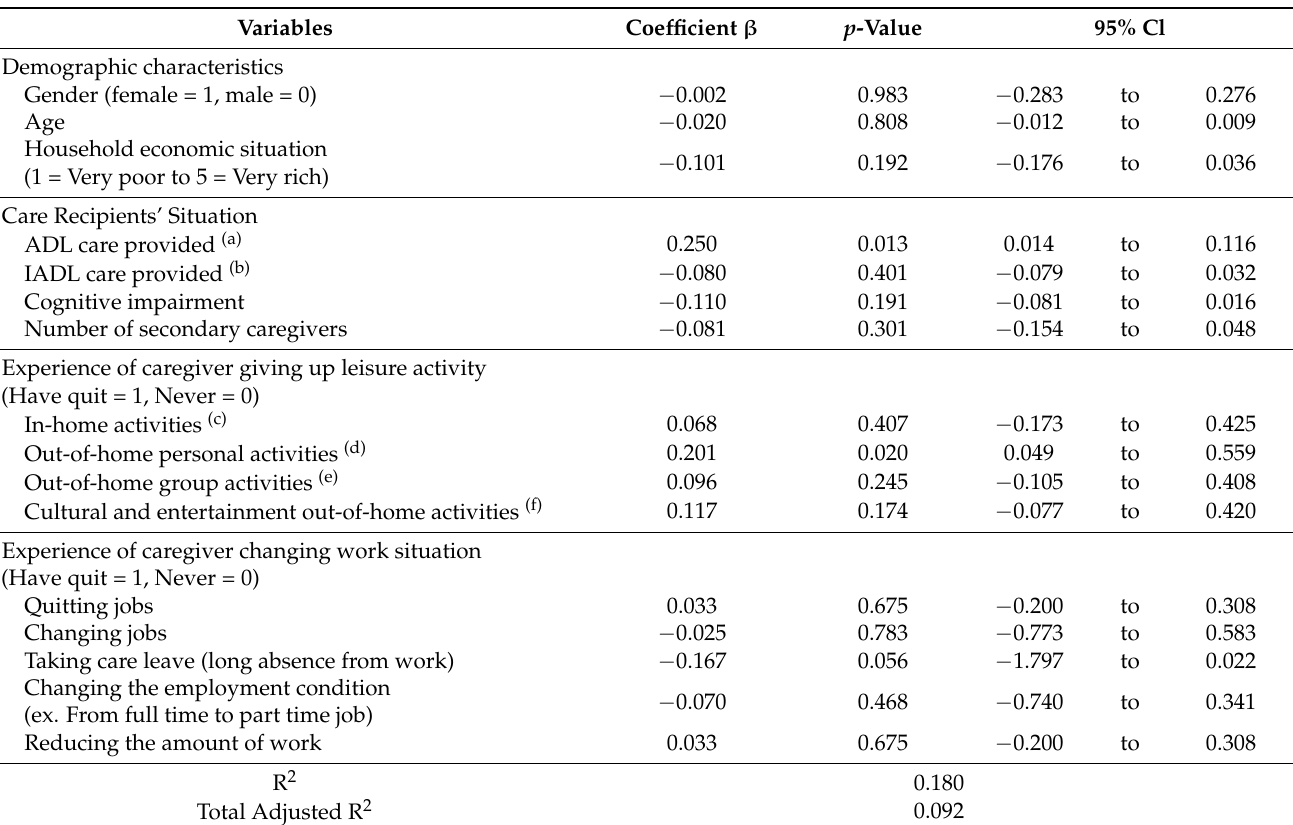
Table 4. Multiple regression analysis results with subjective care burden as the dependent variable ( n = 171).